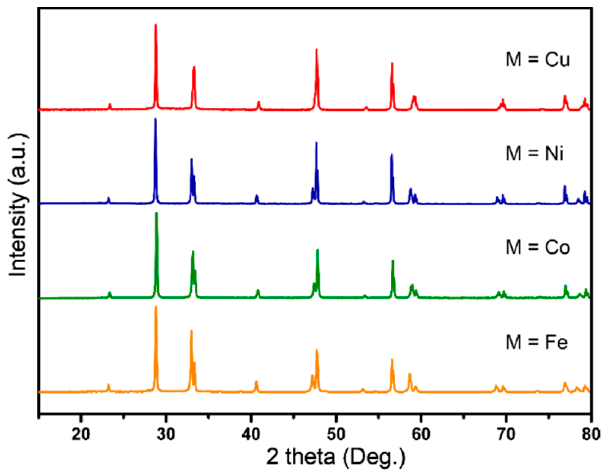
Figure 8. XRD patterns of the spent CPM-PSFA (M = Fe, Co, Ni, Cu) membranes after oxygen permeability test, respectively.